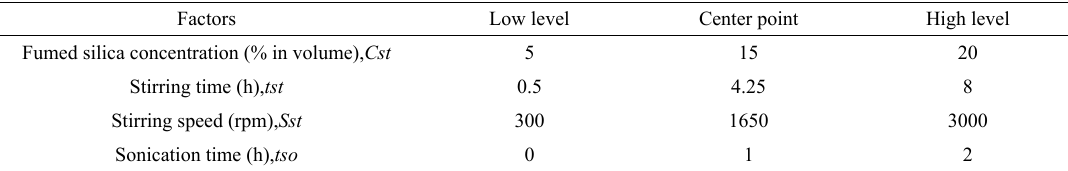
Table 2. Factors and factor